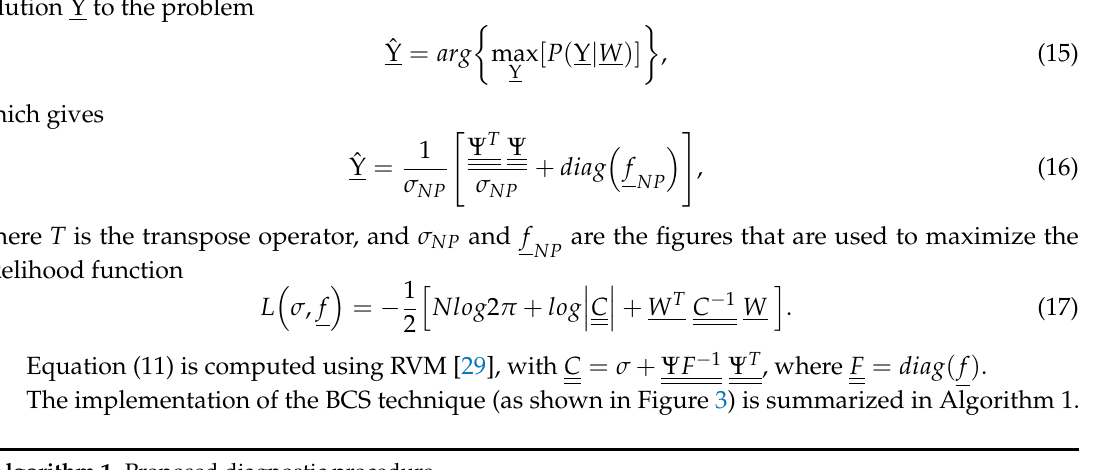
Algorithm 1. Proposed diagnostic